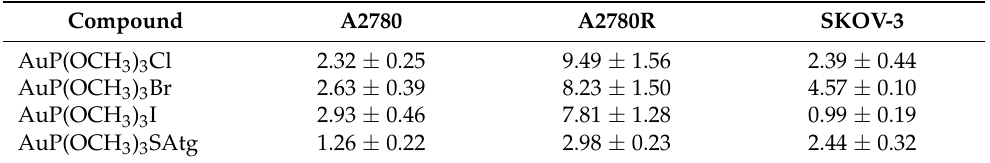
Table 2. In vitro cytotoxicity of the investigated compounds against A2780, A2780R and SKOV-3 ovarian cancer models. IC 50 ( μ M) 1 ± SD.